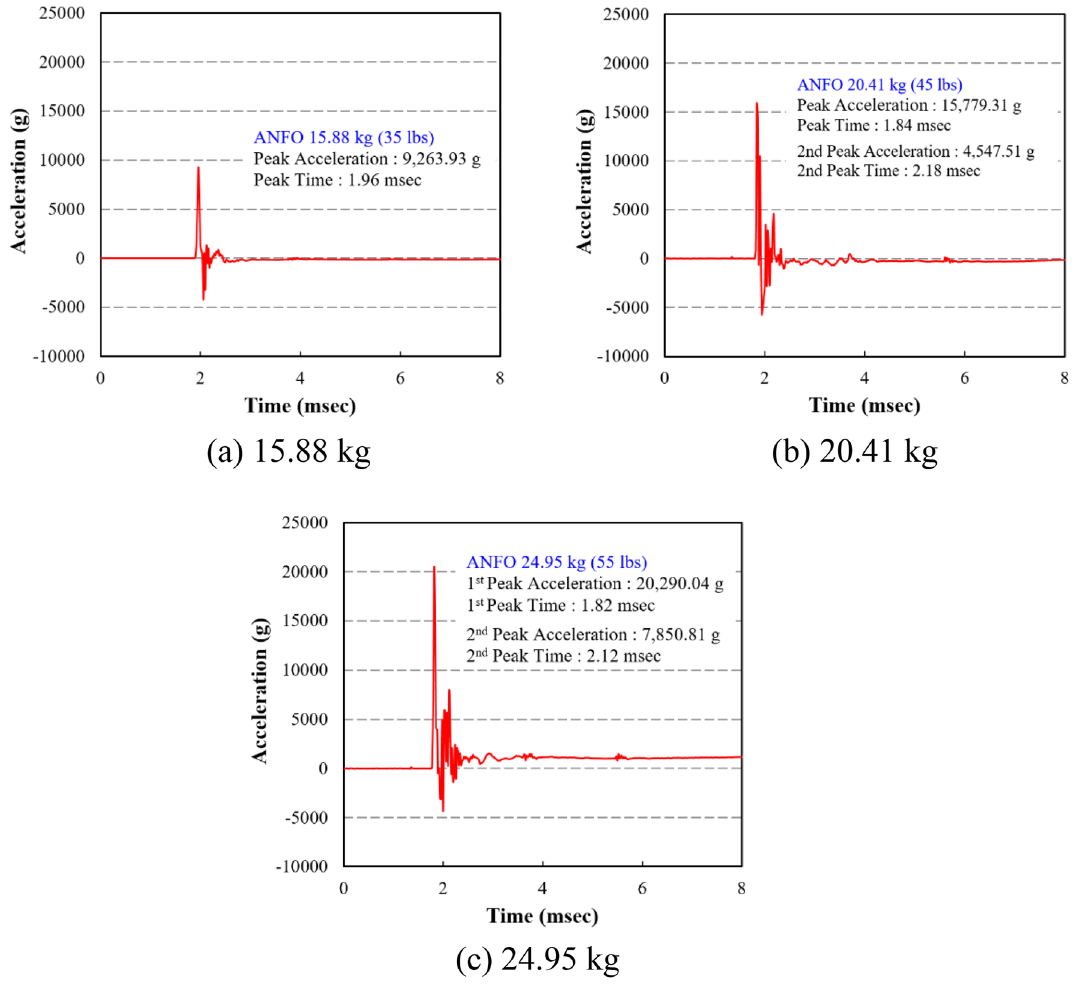
Figure 15. Acceleration results. ( a ) 15.88 kg. ( b ) 20.41 kg. ( c ) 24.95